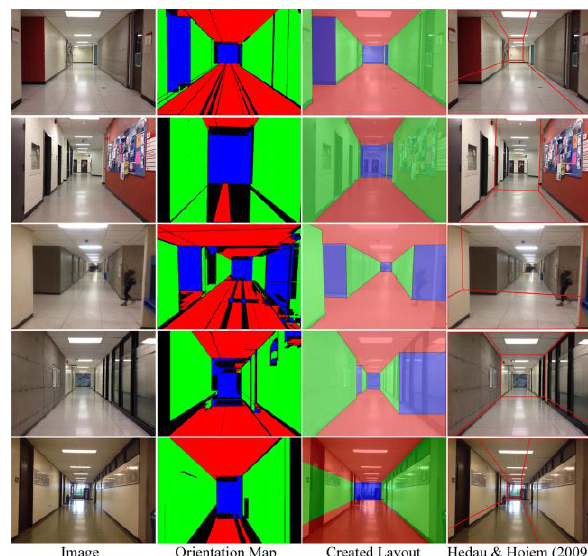
Figure 4. Example of the failure cases due to the wrong corridor depth estimation or misplacement of side cubes.